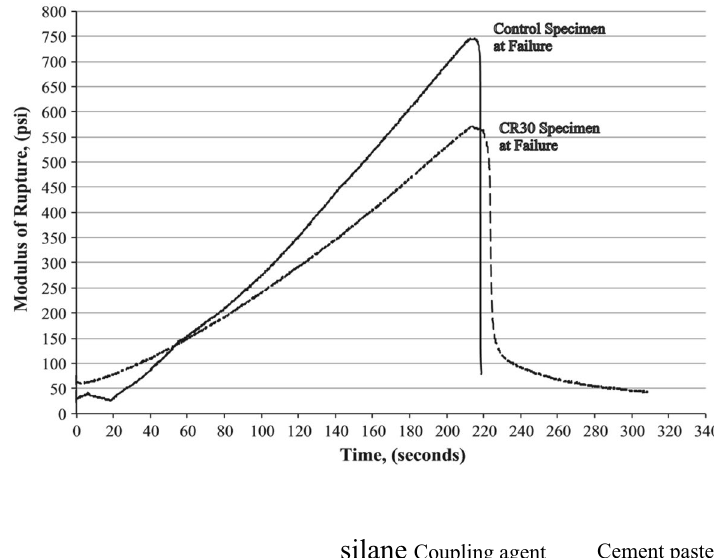
Fig. 11 Surface treatment of rubber particles in two stages